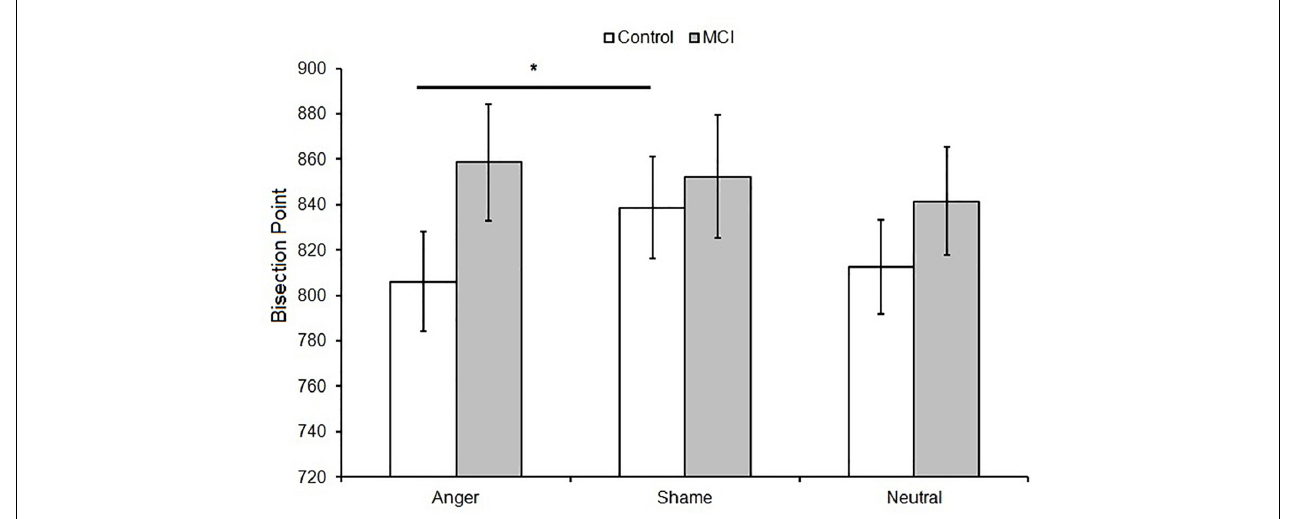
FIGURE 2 | Mean bisection point (BP) as a function of Group (MCI and control) and Emotion (anger, shame, and neutral). Error bars represent the standard error of the mean. ∗ = significant difference p < 0.05.